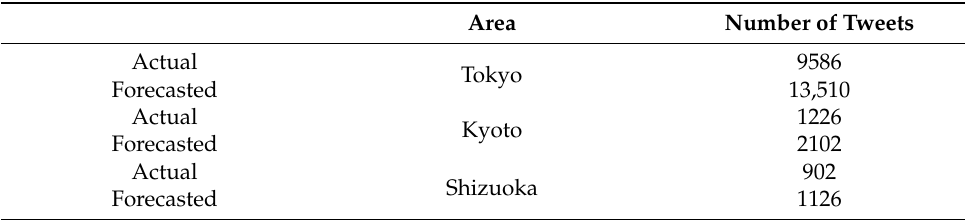
Figure 10. Shizuoka after the forecast in 2019 (proposed method (2)). Table 3. Number of tweets, actual total and the forecasted total (proposed method (2)).